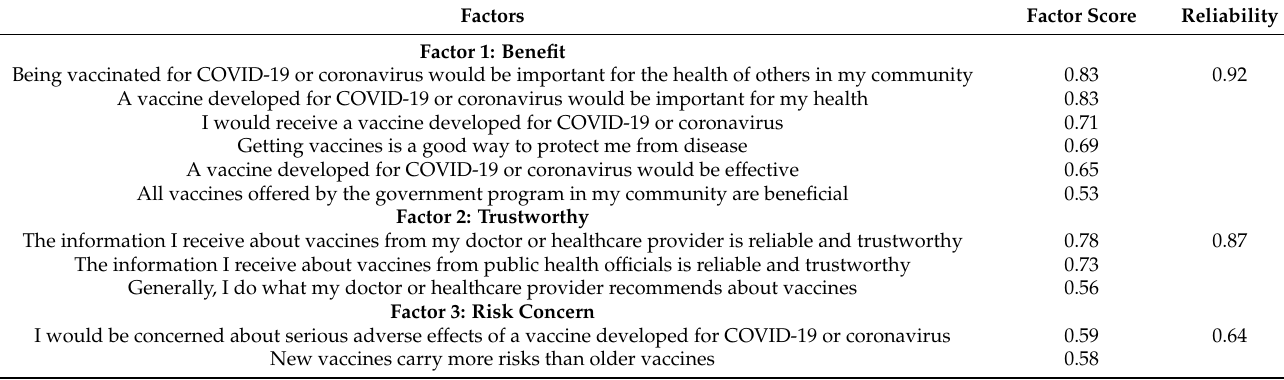
Table 2. Factor analysis and reliability of COVID-19 vaccine hesitancy survey questions.